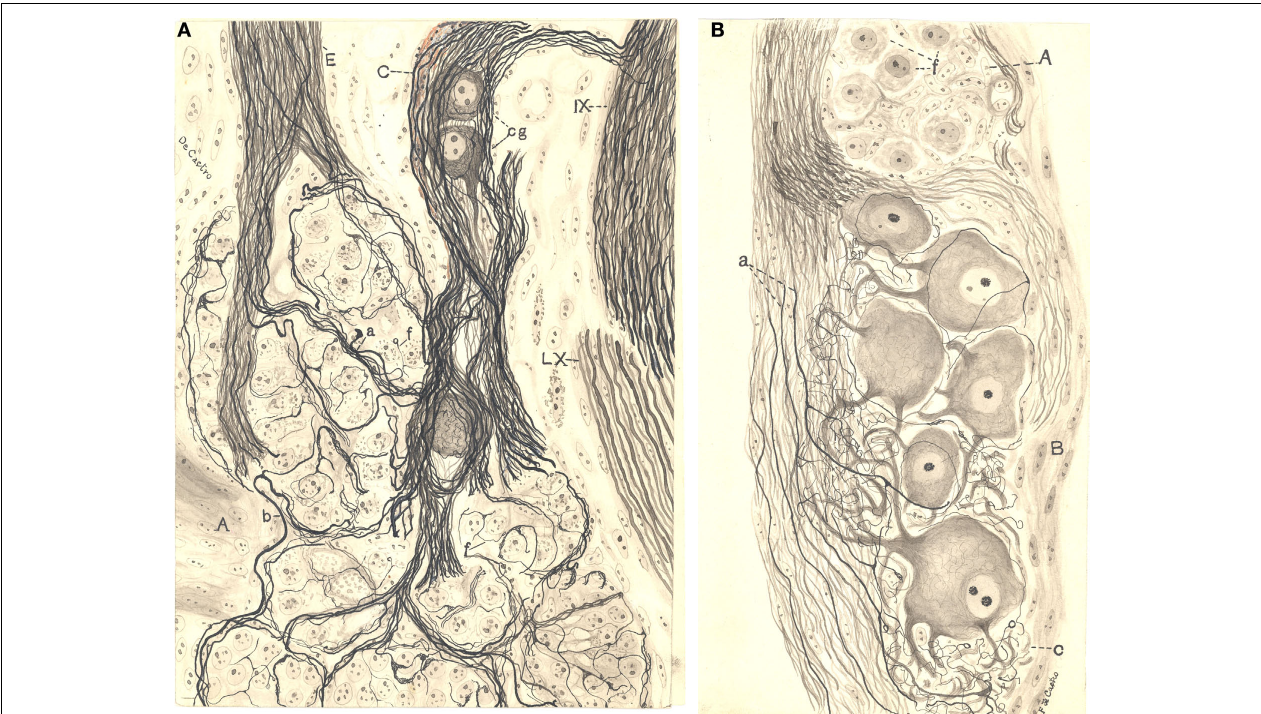
FIGURE 2 | De Castro describes fi ne structure of the carotid body in detail-II (1926). As in the previous fi gure, these are Fernando De Castro’s original drawings from his fi rst publication on the innervation of the carotid region (De Castro, 1926). (A) Illustration of the carotid body, where different glomeruli are close to the carotid artery ( A ). Incoming sympathetic nerve from the superior cervical ganglion ( E ) is a minor contribution to the innervation of the